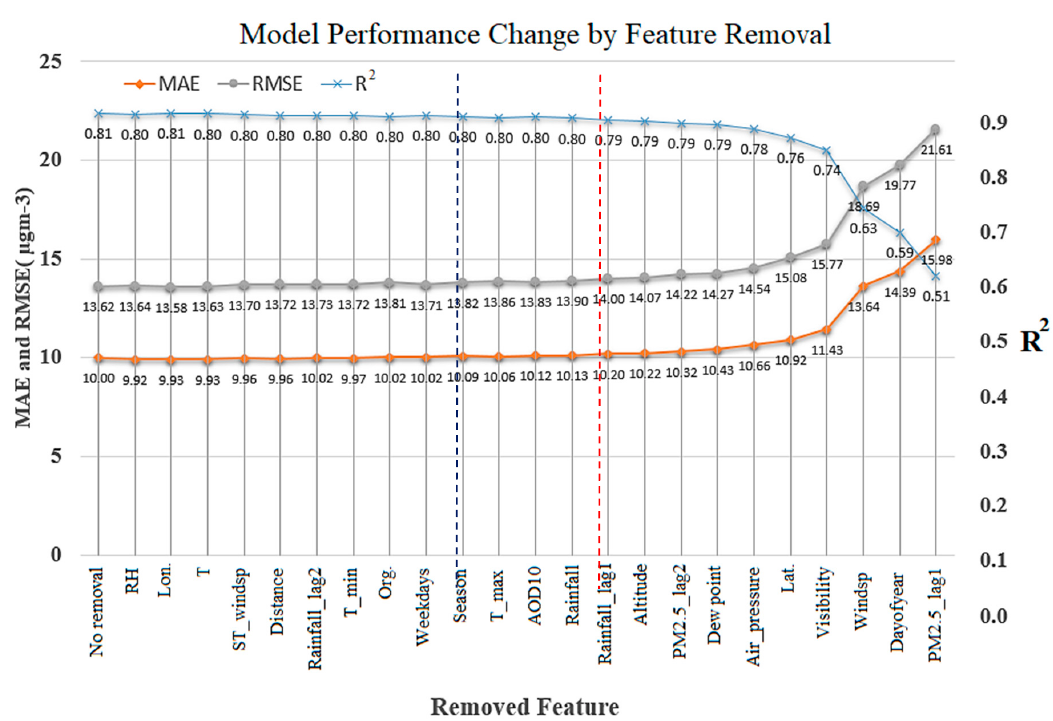
Figure 8. Feature removal using the XGBoost machine learning method, based on MAE metrics. In each step, one feature was removed based on its impact on model performance. From the dotted red line to the right side, features have higher impact on model performance than features on the left side. From the left side of the figure to the blue line, MAE is still below 10 µg/m 3 .